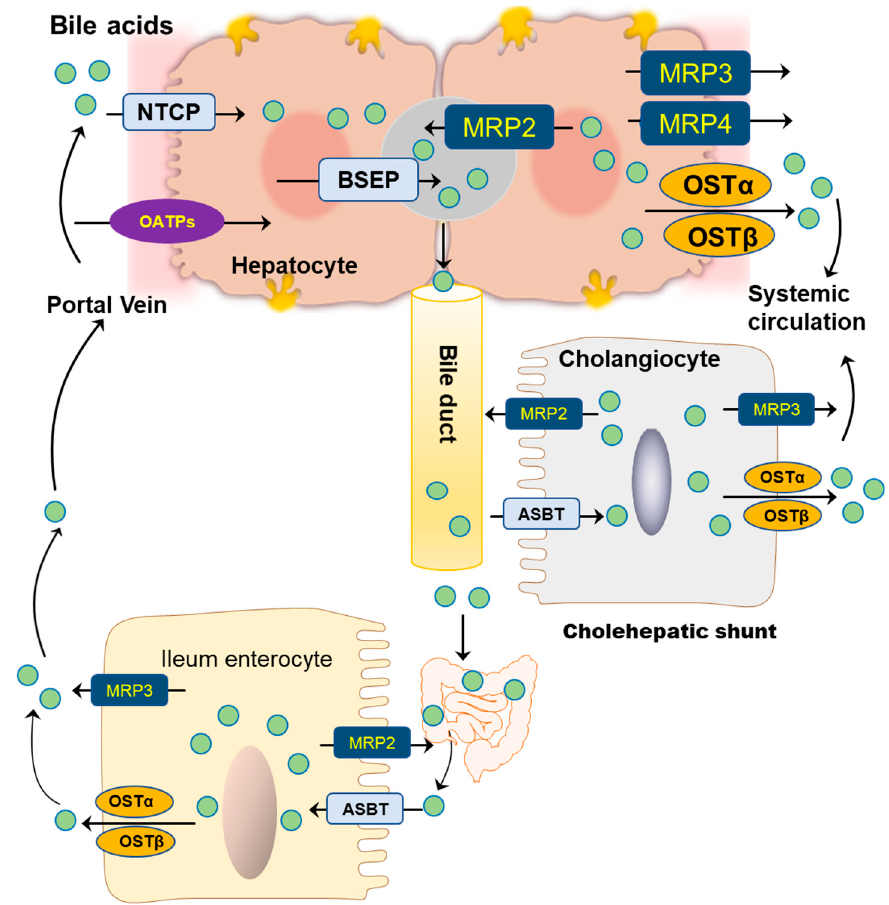
Figure 4. Bile acid transporters in hepatocytes, cholangiocytes, and ileum enterocytes.